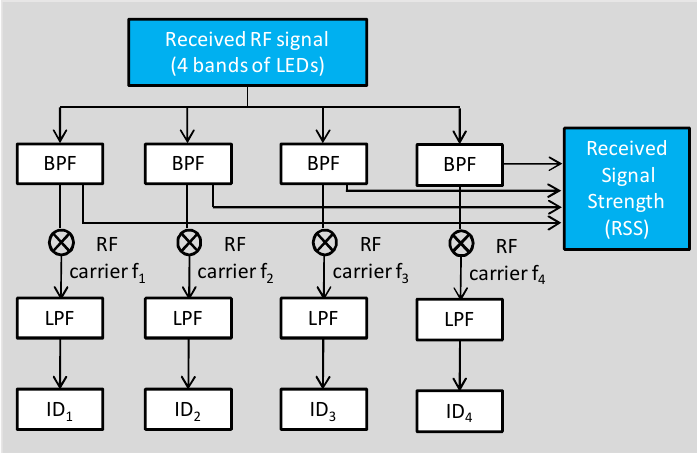
Figure 2. Rx architecture to decode the 4 IDs and 4 RSS values. BPF: band-pass filter; LPF: low-pass filter.